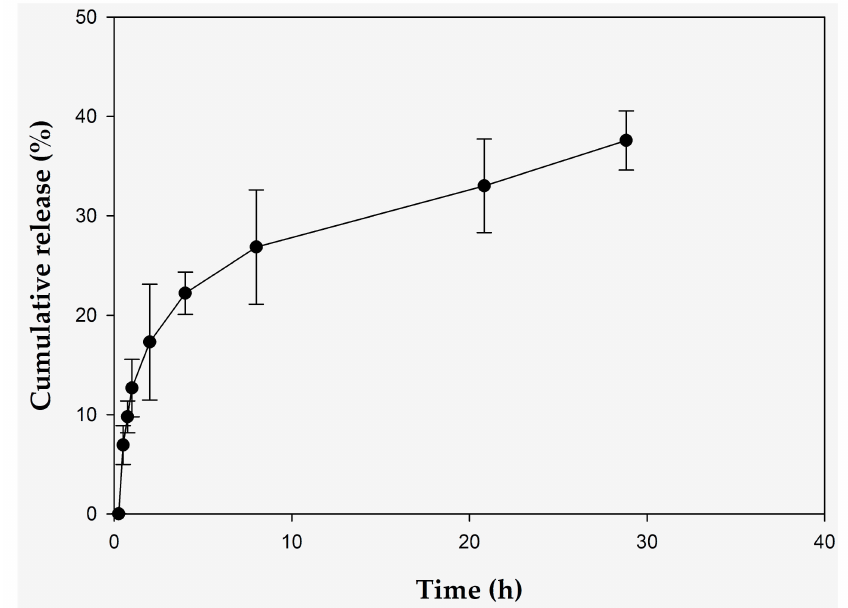
Figure 1. In vitro release of 10-hydroxydecenoic acid (10-HDA) of RJDS for time 0 to 8 h. The results are shown as the mean ± SD of three